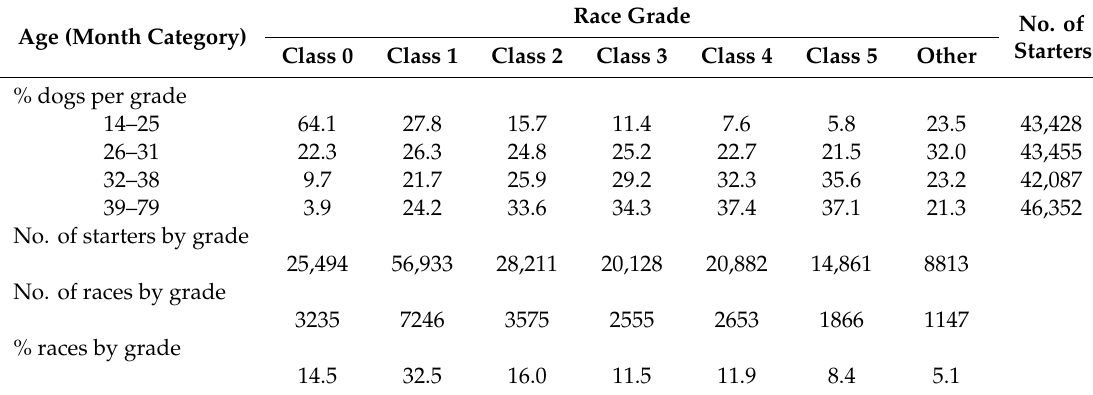
Table 1. The distribution (number and percentage) of greyhounds racing by age and racing class for the 2013–2016 racing seasons in New